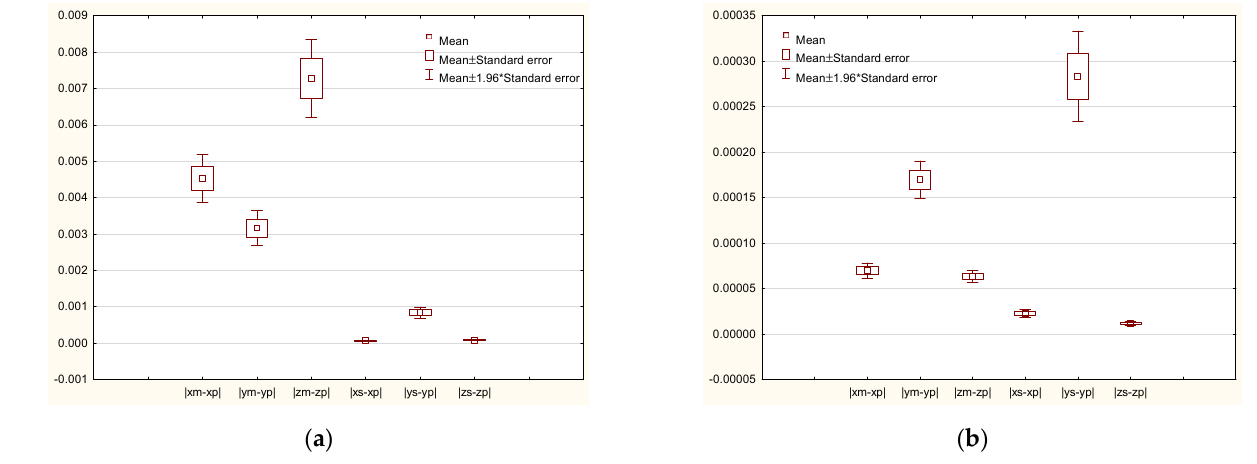
Figure 9. Comparing the results from the analytical ( a ) and network ( b ) model. Denotations xm-xp—errors for analytic (1) model, xs-xp—errors for the ANN.